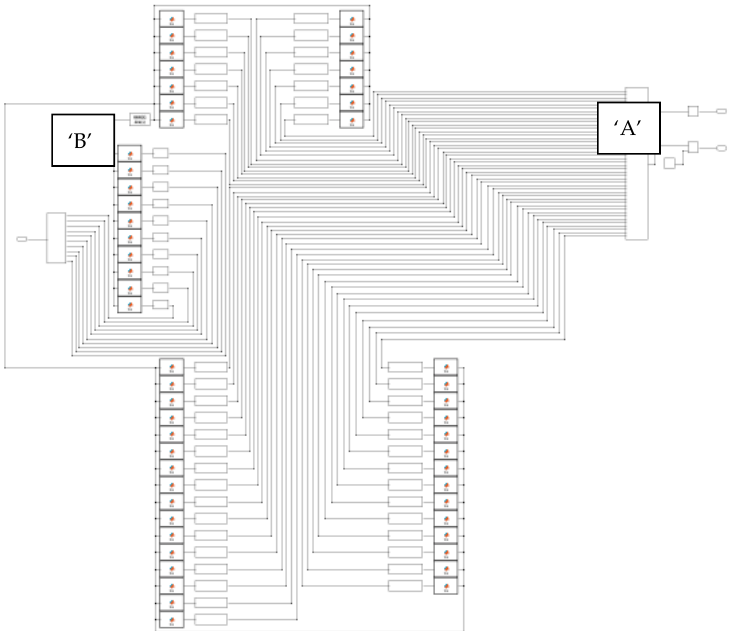
Figure 8. The subsystem of electrolyzer cell stack (places ‘A’ and ‘B’ are shown in the next figures).